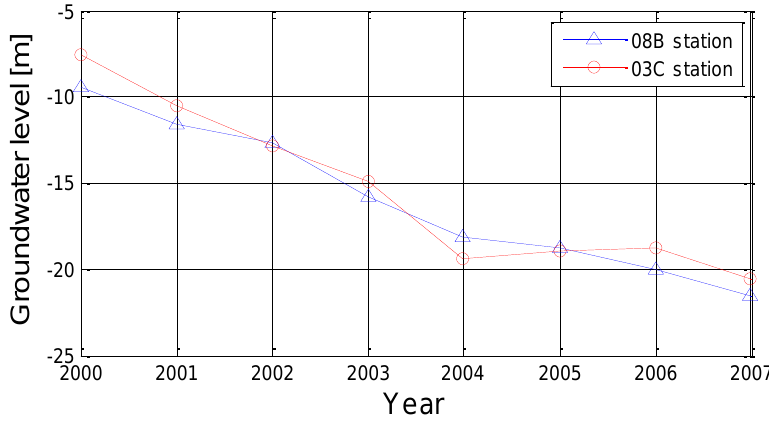
Figure A1. Time series groundwater table at two example stations.